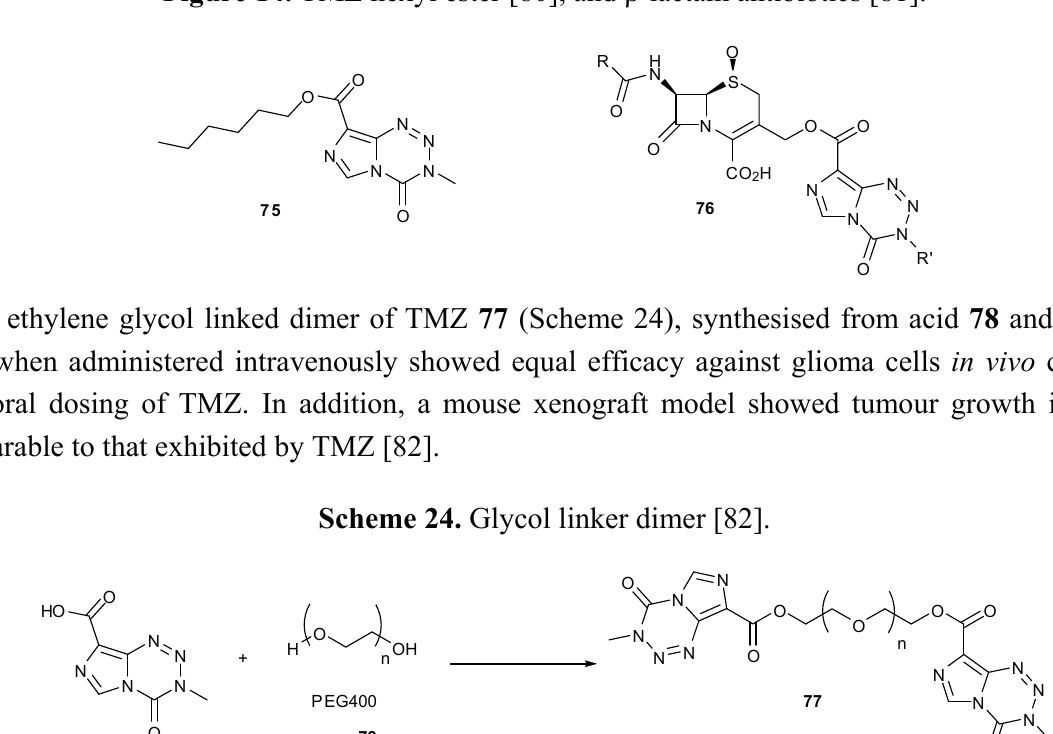
Figure 14. TMZ hexyl ester [80], and β -lactam antibiotics